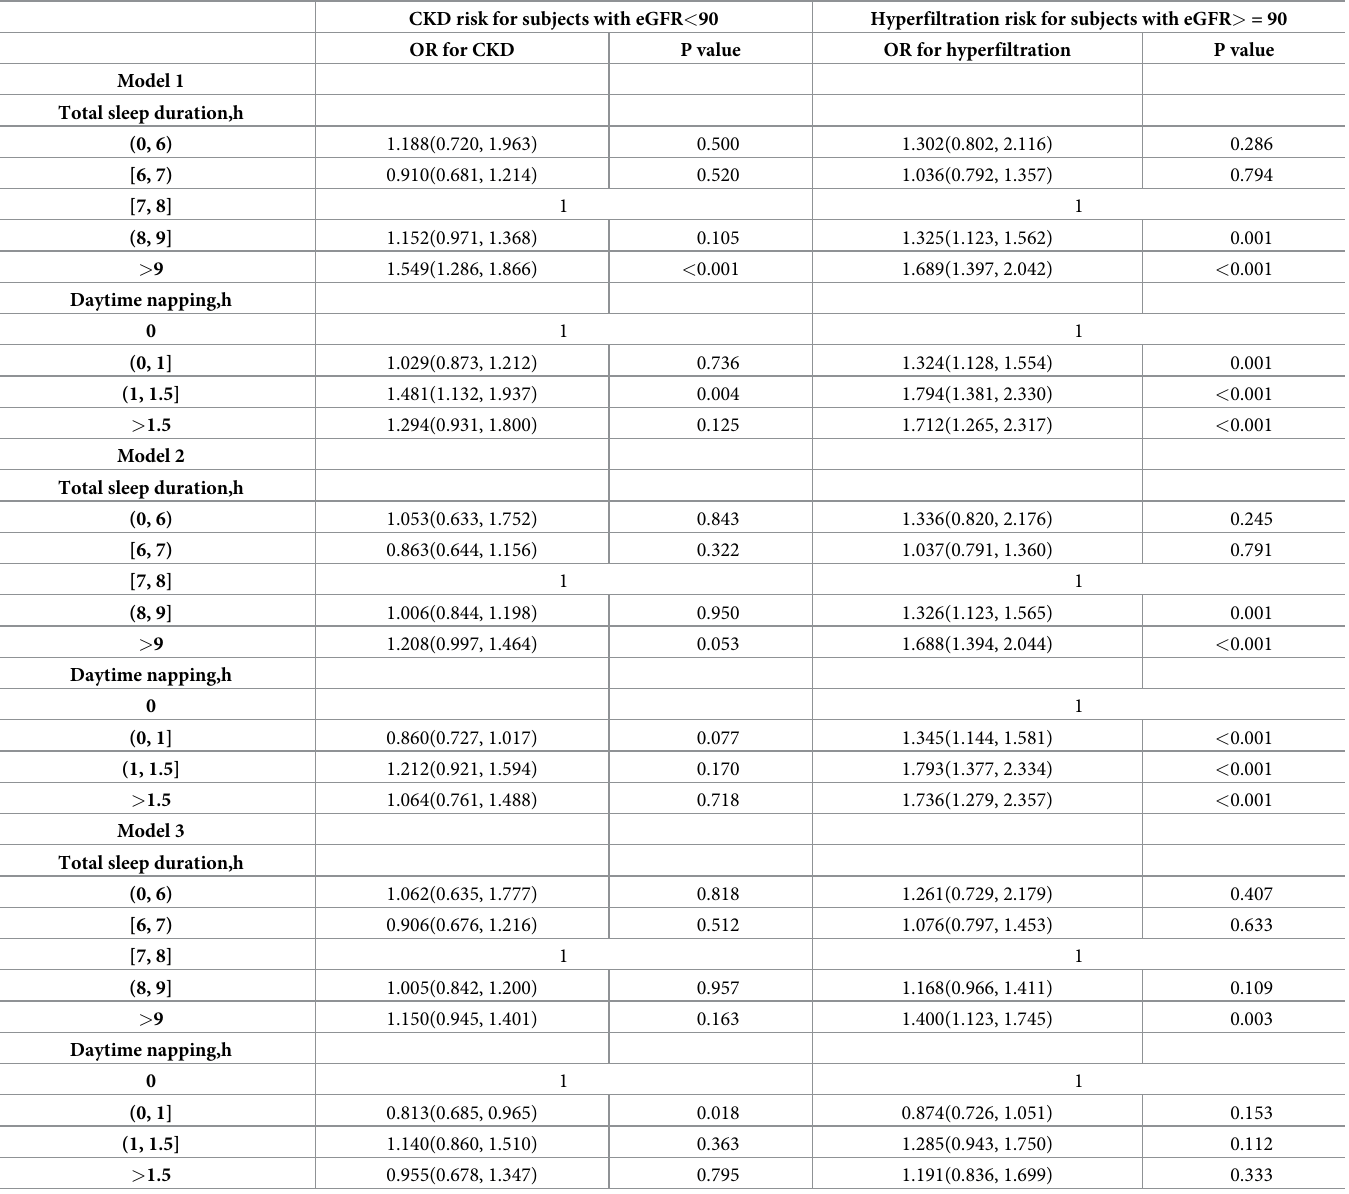
Table 4. Relationships between total sleep duration, daytime napping and